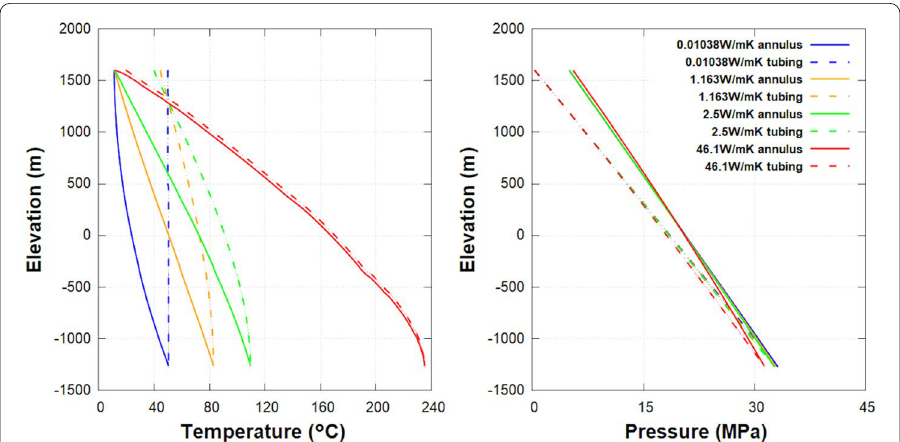
Fig. 6 Thermal conductivity analysis in inner casing (Casg1) over 30 years. Left—temperature vs. elevation for various (cid:31) ( W / mK ) . Right—pressure vs. elevation for various (cid:31) ( W / mK ) . Solid lines represent annulus and dashed lines represent tubing data, respectively. Legend applies to both graphs. All cases were compared to the base-case graph (in blue)